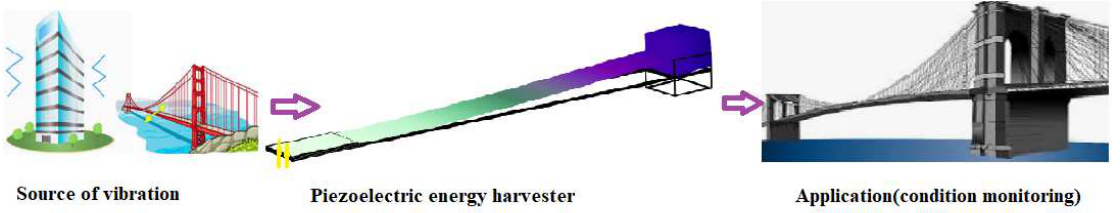
Figure 1. Energy harvesting from vibrations of bridges and buildings used in condition. Monitor- ing.